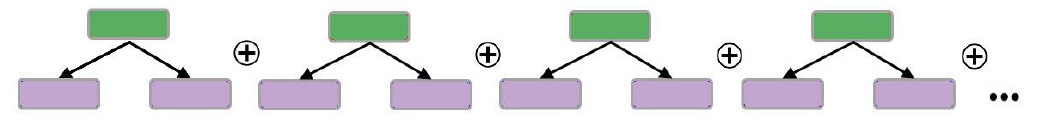
Figure 3. Schematic diagram of AdaBoost classifier.